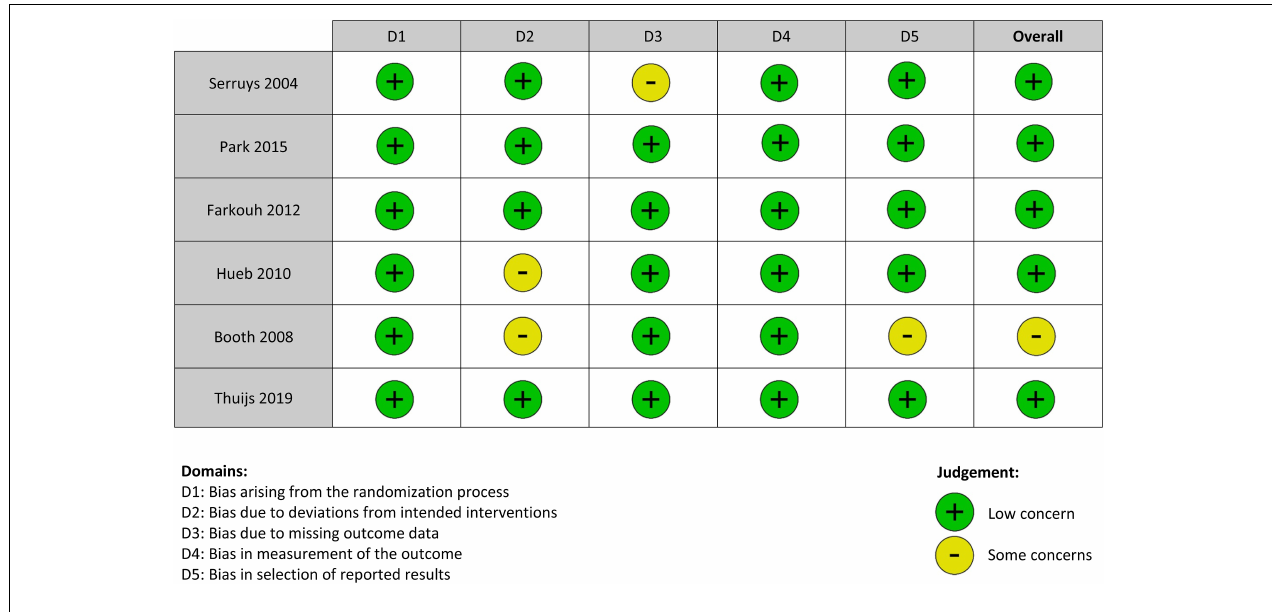
FIGURE 2 | Risk of bias